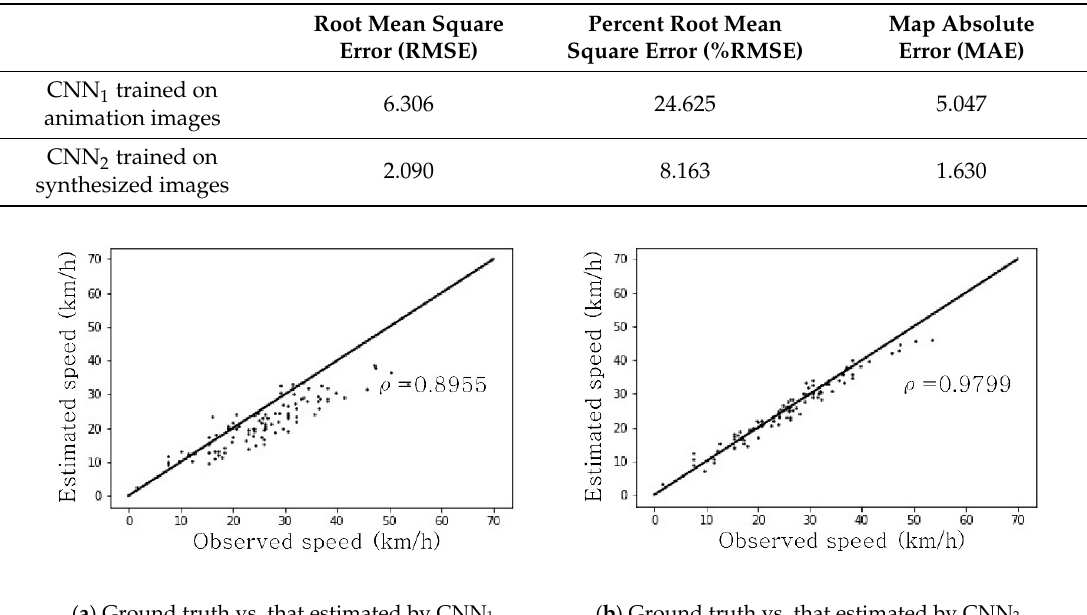
Figure 13. Comparison between observed and estimated space mean speeds estimated using real photos. ρ : Correlation coefficient.